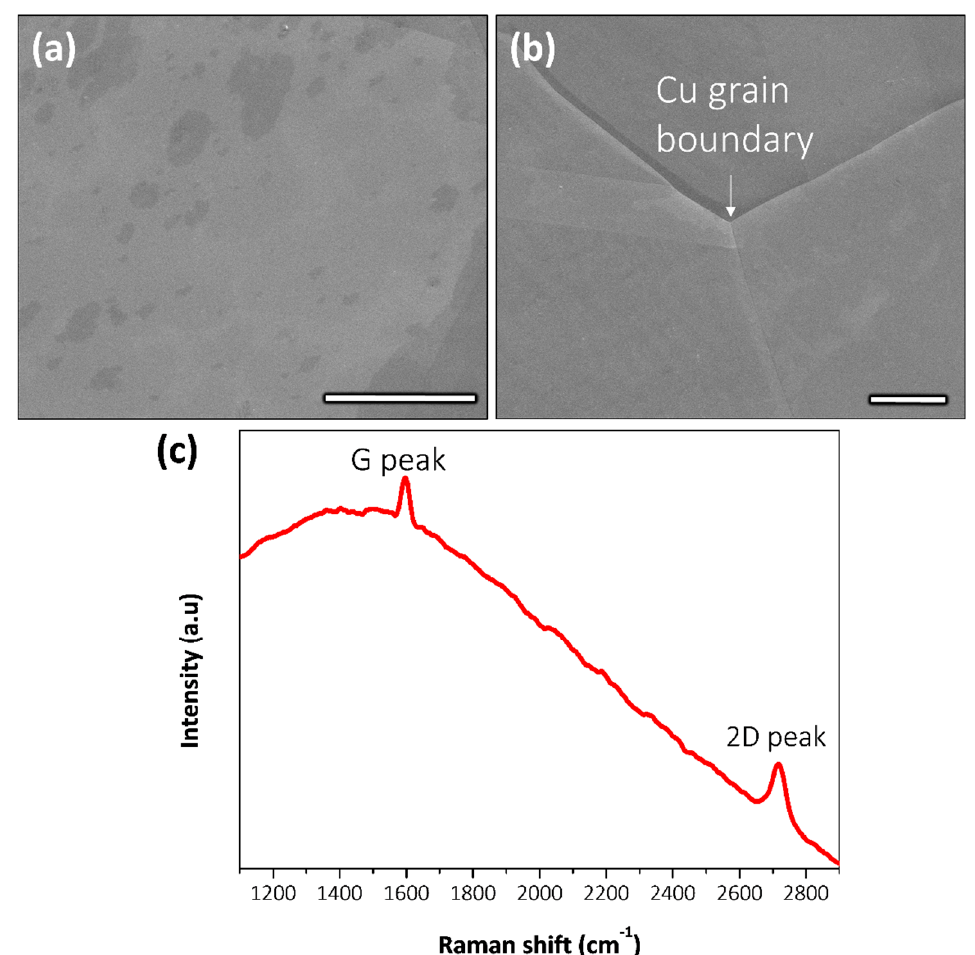
Figure 2. ( a , b ) SEM characterization of continuous and clean graphene grown on a Cu foil. The arrows in ( b ) indicate the presence of the Cu grain boundaries; ( c ) Raman spectroscopy performed on graphene on Cu foil, showing the two typical peaks of graphene; G and 2D at 1580 and 2680 cm − 1 , respectively. The absence of the defect-related D peak at 1350 cm − 1 confirms the growth of high-quality graphene. Scale bar: 5 µm.